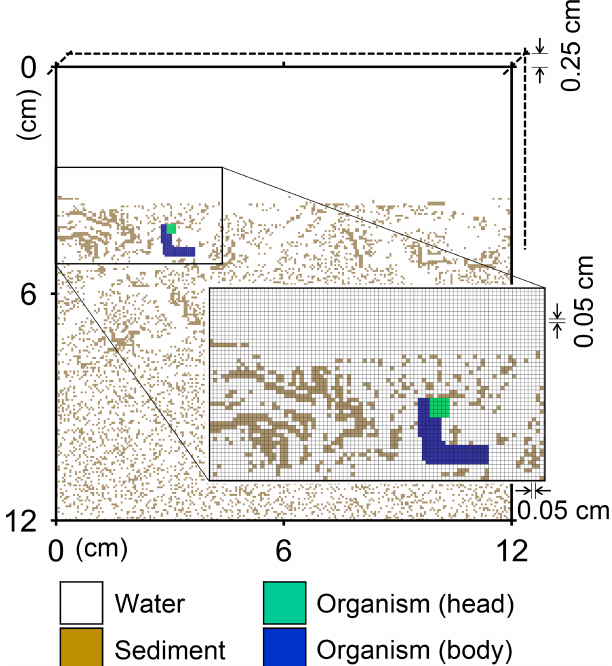
Figure 1. Illustration of grid on which the behavior of a benthic organism is simulated by LABS. Note that the left and right bound- aries of the grid are continuous. Shown in the lower right is a mag- nified view where each grid cell (0 . 05 × 0 . 05cm 2 ) is visible. Dashed lines are drawn to show the implicit width of the system with which the 2-D grid system can be converted to a 3-D system.